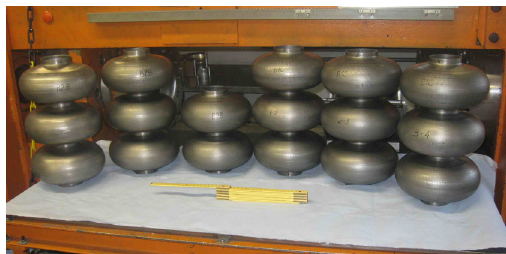
FIG. 27. Three- and two-cell units, hydroformed from BL-WC